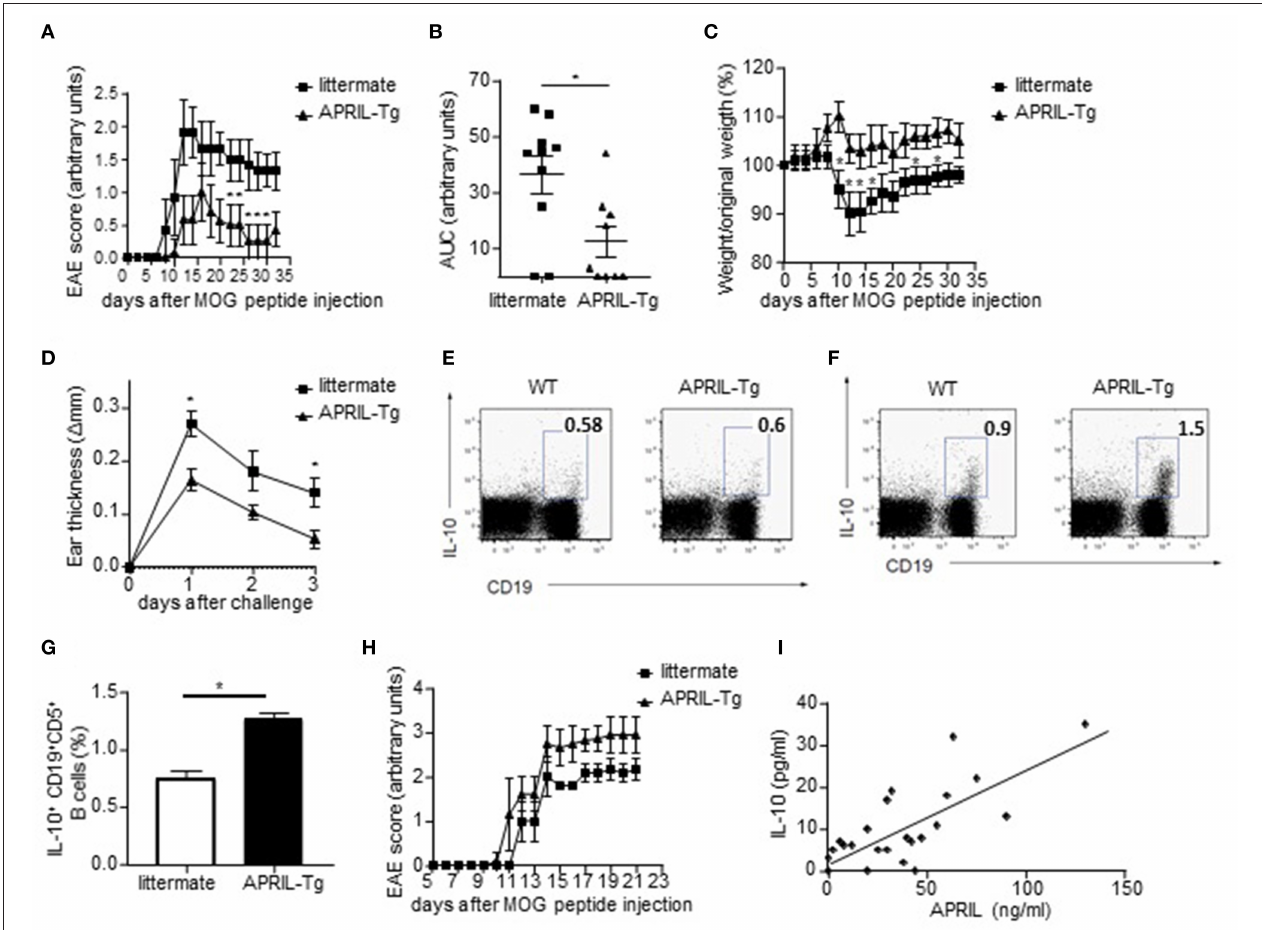
FIGURE 8 | APRIL driven amelioration of EAE and CHS is associated with the induction of IL-10-producing regulatory B cells. (A–C) EAE was induced in APRIL transgenic ( n = 10) and wild type mice ( n = 9). APRIL-Tg mice had a decreased disease development, determined by disease score (A) and area under the curve for disease score (B) , and a lower weight loss compared to control mice (C) . The weight loss is given by the ratio of weight at the indicated time point vs. original weight. (D–F) Control and APRIL-Tg mice were immunized with oxazolone according to the CHS protocol. (D) Sensitized littermates ( n = 4) and APRIL-Tg mice ( n = 5) were challenged with oxazolone and ear thickness was measured 1, 2 and 3 days after the challenge. (E) No altered IL-10 production in splenocytes of unchallenged APRIL-Tg and control mice. A representative FACS staining is shown. (F) Representative FACS staining of IL-10 producing splenic B cells in APRIL-Tg and littermate mice 3 days after the challenge. (G) Quantitative analysis of peritoneal B cells for IL-10 production in sensitized mice 3 days after oxazolone challenge ( n = 5). (H) Depletion of peritoneal B1 cells by hypotonic shock abolishes the disease modulating effect of ectopic APRIL expression in EAE. Distilled water-treated APRIL-Tg mice ( n = 8) are equally susceptible to EAE as WT controls ( n = 8). (I) Concentrations of APRIL and IL-10 were measured in the synovial fluids of patients with inflammatory arthritis ( n = 24). Correlations were calculated using Spearman’s rank order correlation. (A–H) Mean ± SD are shown, * P < 0.05 (Mann-Whitney U